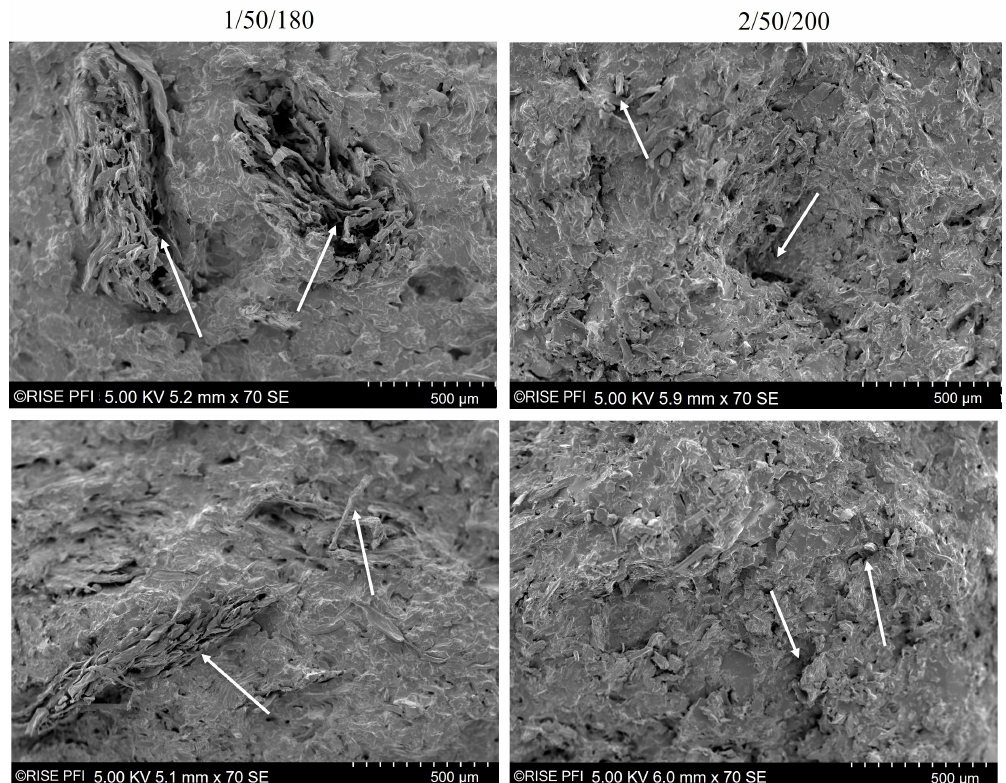
Figure 7. SEM images with 70 × magnification of fractured surfaces of a tensile test specimens from series 1/50/180 ( left ) and series 2/50/200 ( right